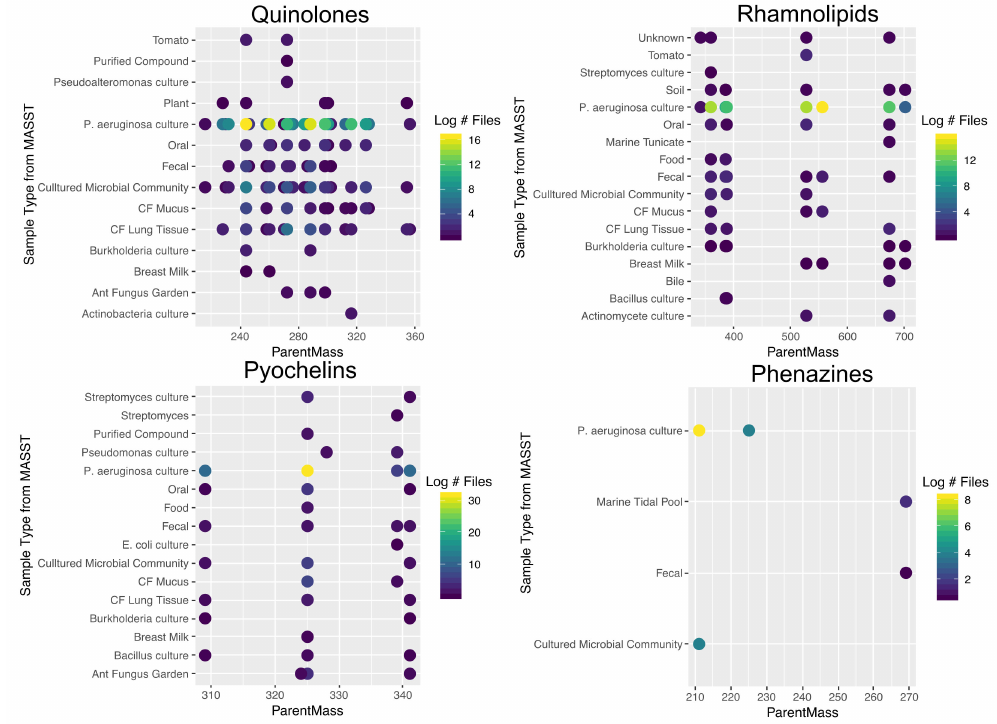
Figure 4. Presence of P. aeruginosa specialized metabolites in di ff erent sample types on GNPS after MASST searching. Each point represents a unique MS / MS spectrum searched with MASST and the points are colored by the log 10 number of files that the compounds was detected in within that sample